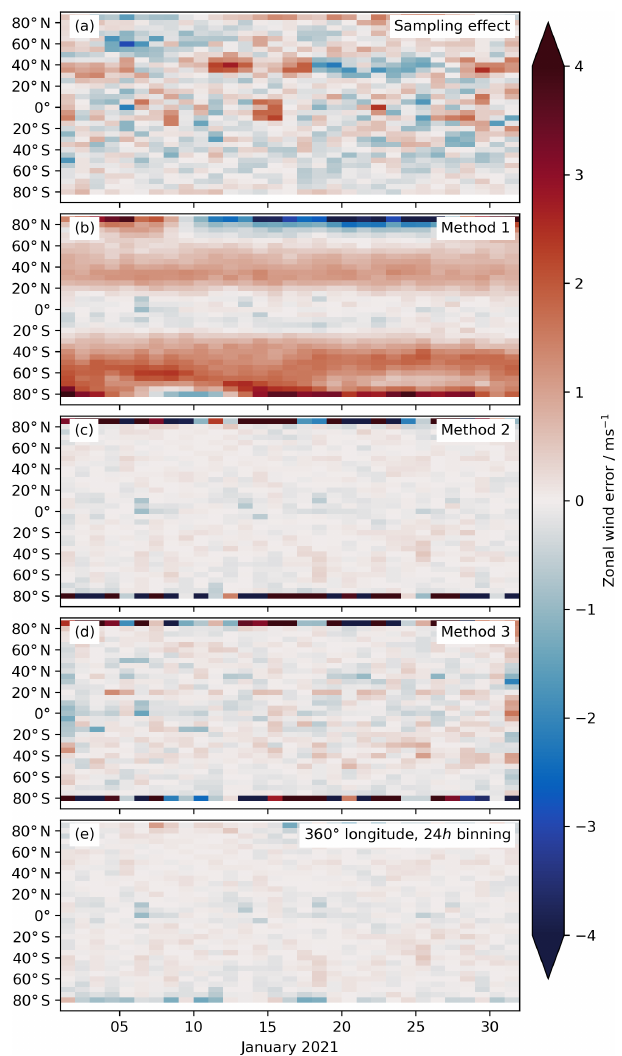
Figure 9. Absolute errors in the daily zonal mean zonal wind cal- culation for January 2021. Panel (a) shows errors originating in the Aeolus sampling, panels (b) – (d) the errors when using the three conversion methods, respectively, and panel (e) the errors for Method 3, but with a slightly different colocation/binning al- gorithm. The sampling bias shown in panel (a) has been removed from the error estimates in panels (b) – (e)